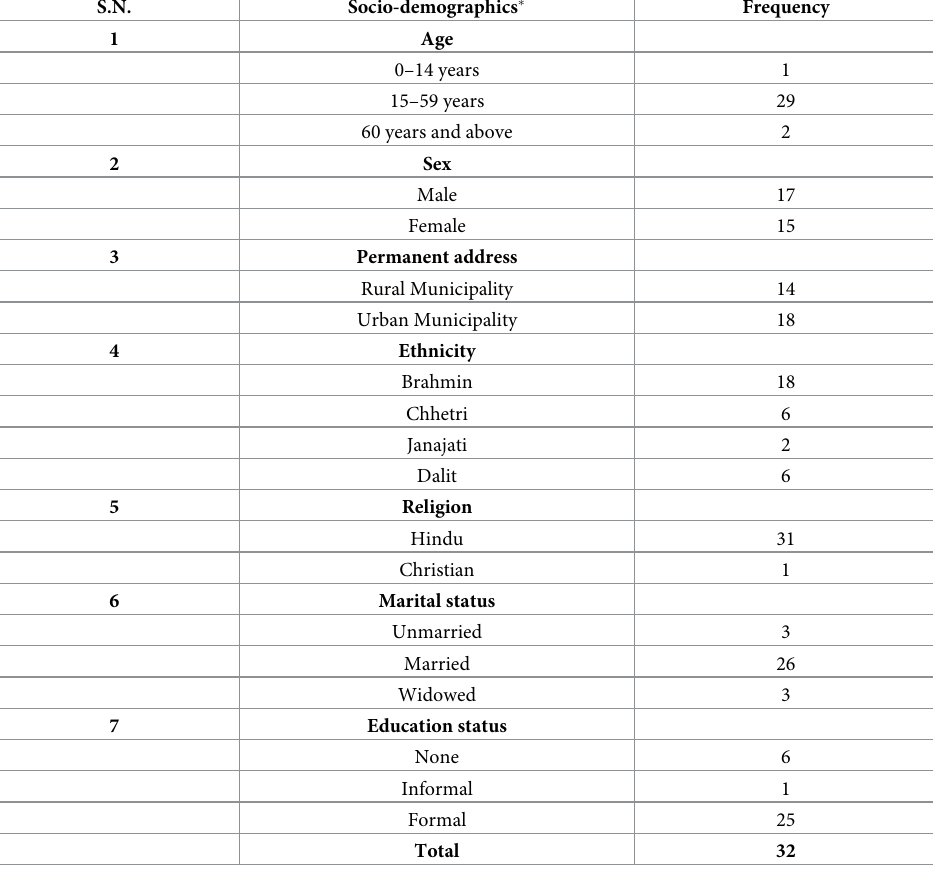
Table 2. Socio-demographics of the